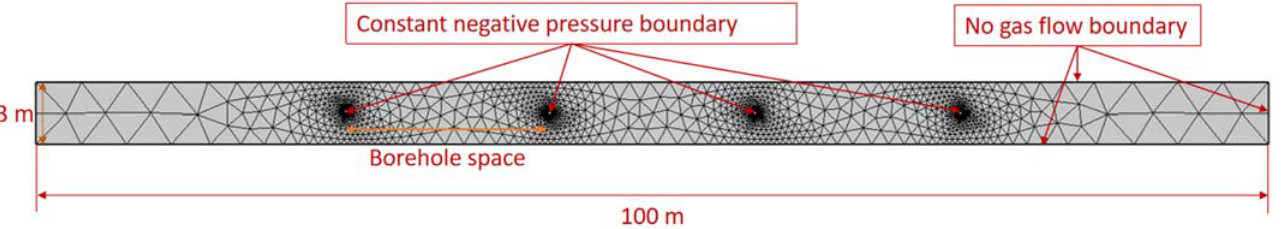
Figure 3. Schematic diagram of the geometric model for simulations.